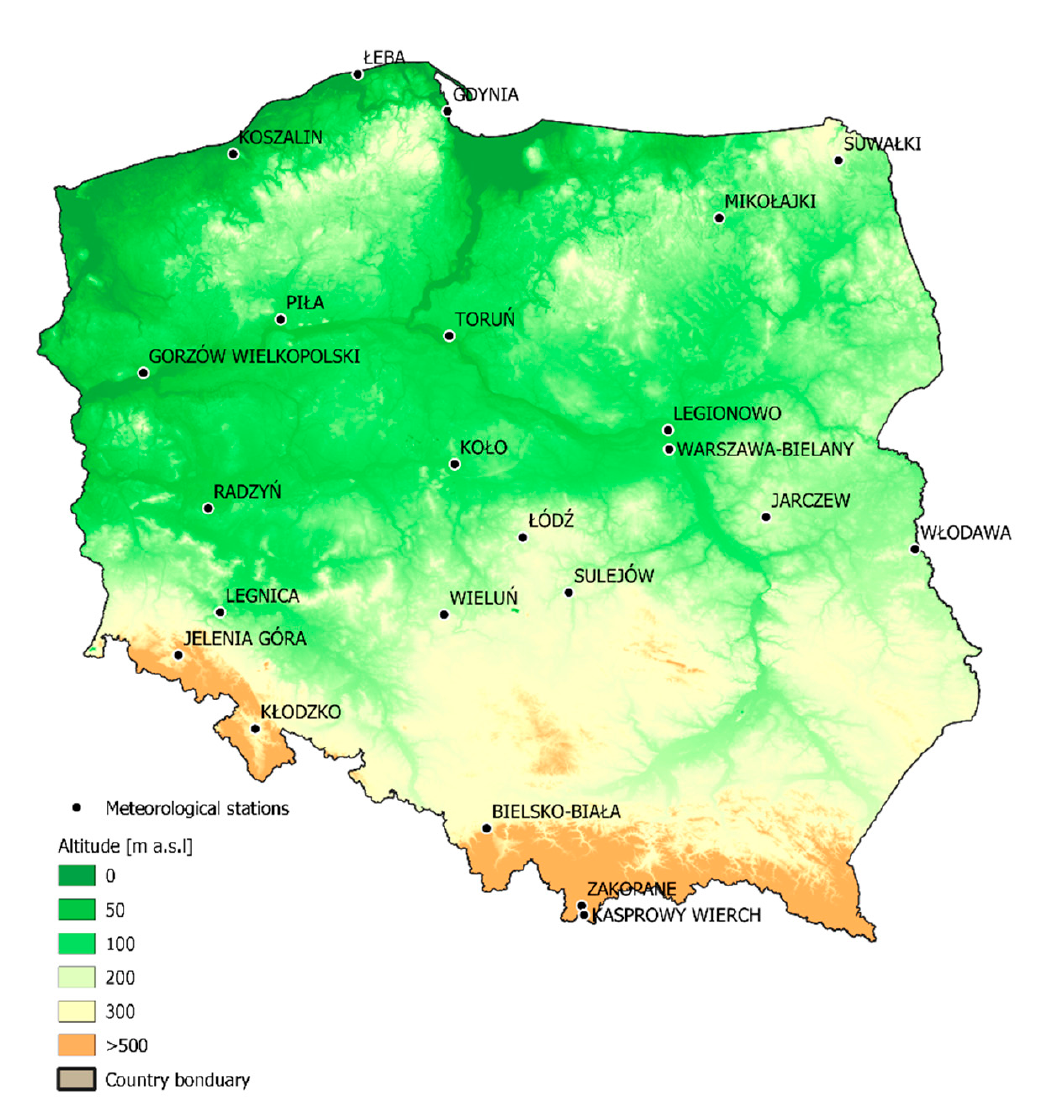
Figure 1. Locations of 23 IMWM-NRI meteorological stations.